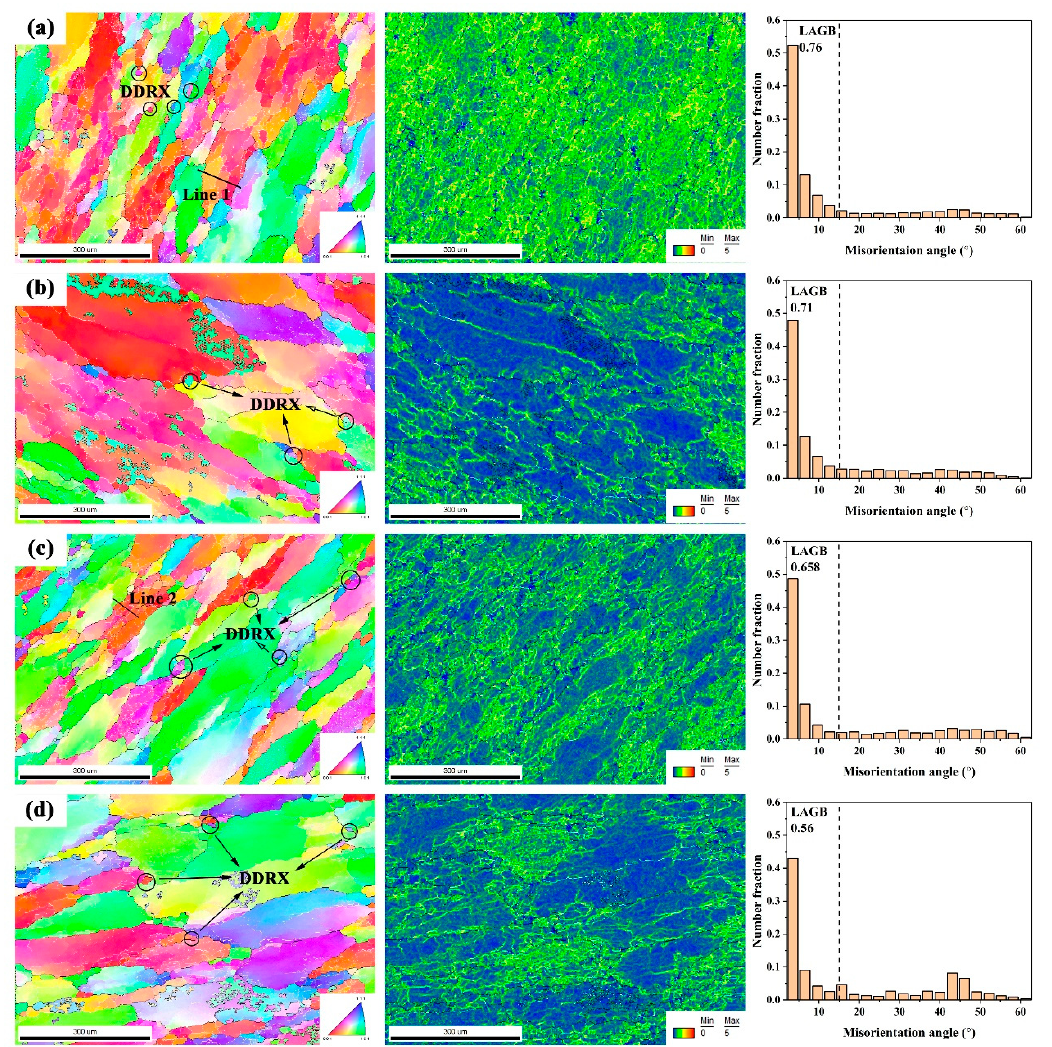
Figure 9. EBSD and KAM figures of samples after second compression at 950 °C with 0.56 strain and a first-pass deformation temperature of ( a ) 700 °C, ( b ) 750 °C, ( c ) 800 °C, ( d ) 850 °C.